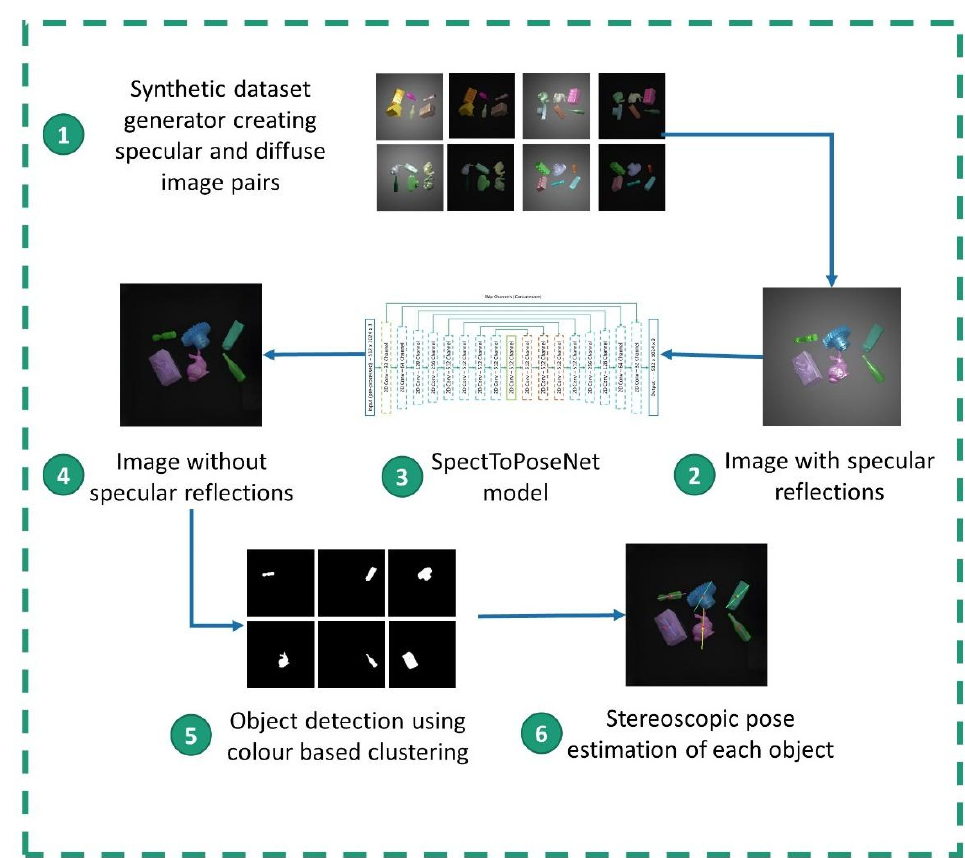
Figure 2. An overview of the proposed SpecToPose system that consists of three main components: a dataset generator, a DL-based specular reflection remover, and a built-in object detector plus pose estimator.